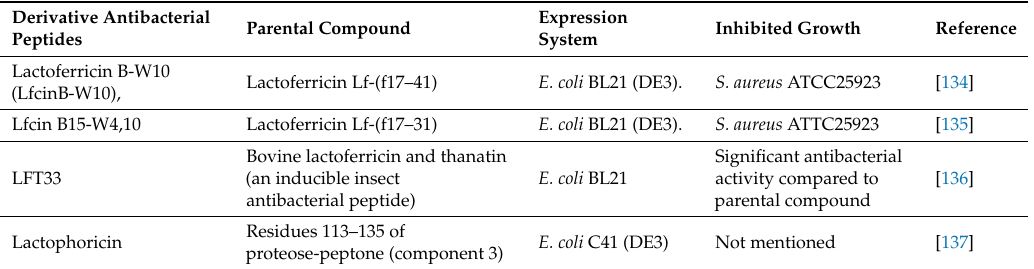
Table 5. Synthesis of milk-derived ABPs by recombinant DNA